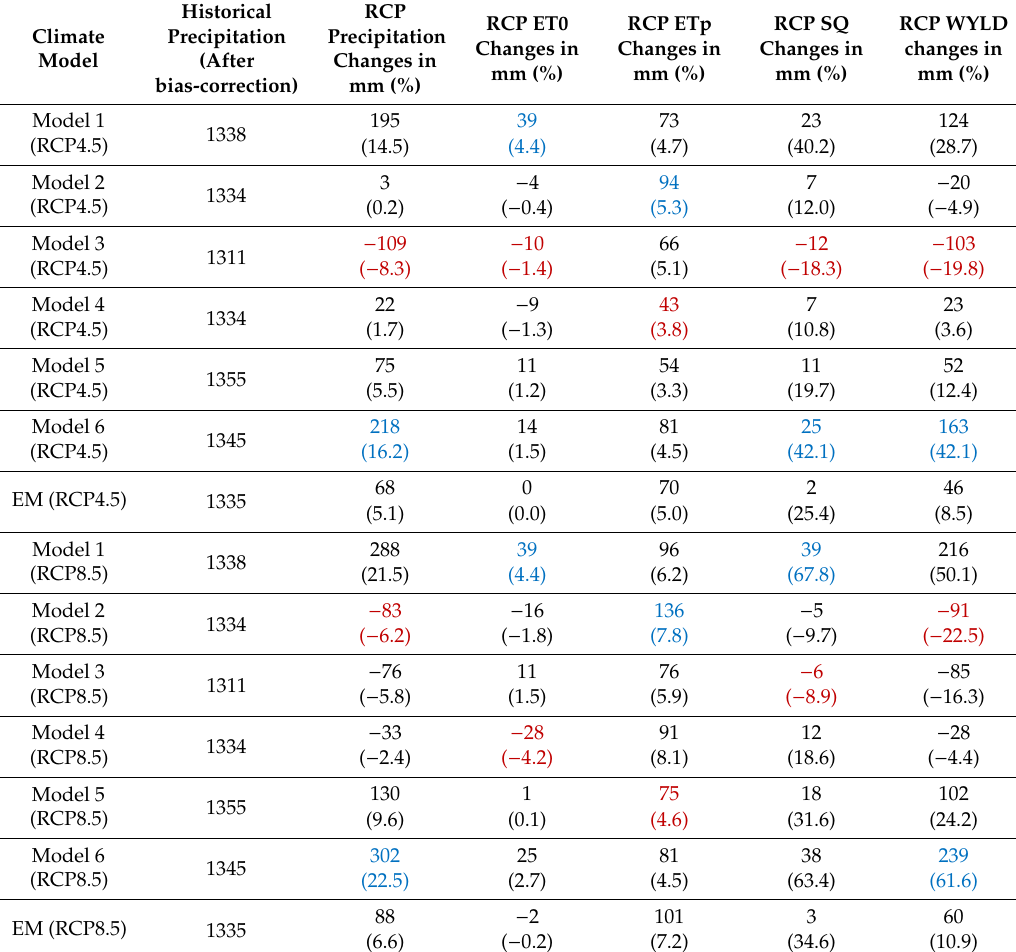
Table 4. Historical annual average precipitation according to the bias-corrected RCM simulations (1951–2005) and the absolute and relative changes of precipitation, and related impacts on selected water balance components in SWAT simulations (2010–2060) according to the projections based on RCP4.5 and RCP8.5 scenarios. Numbers in parentheses represent the changes in percentage. For each parameter (except for the historical precipitation) and RCP scenario, the lowest and highest values according to the absolute changes are highlighted in red and blue, respectively. EM represents the ensemble mean, ET0 the actual evapotranspiration, ETp the potential evapotranspiration, SQ the surface runo ff , and WYLD the overall water